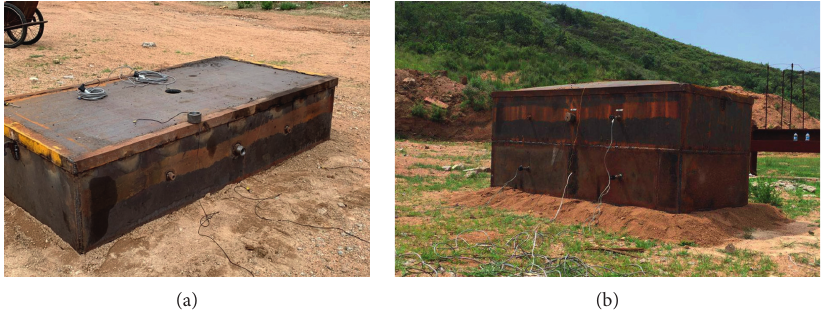
Figure 2: Photograph of simulated chambers. (a) Simulated chamber 1. (b) Simulated chamber